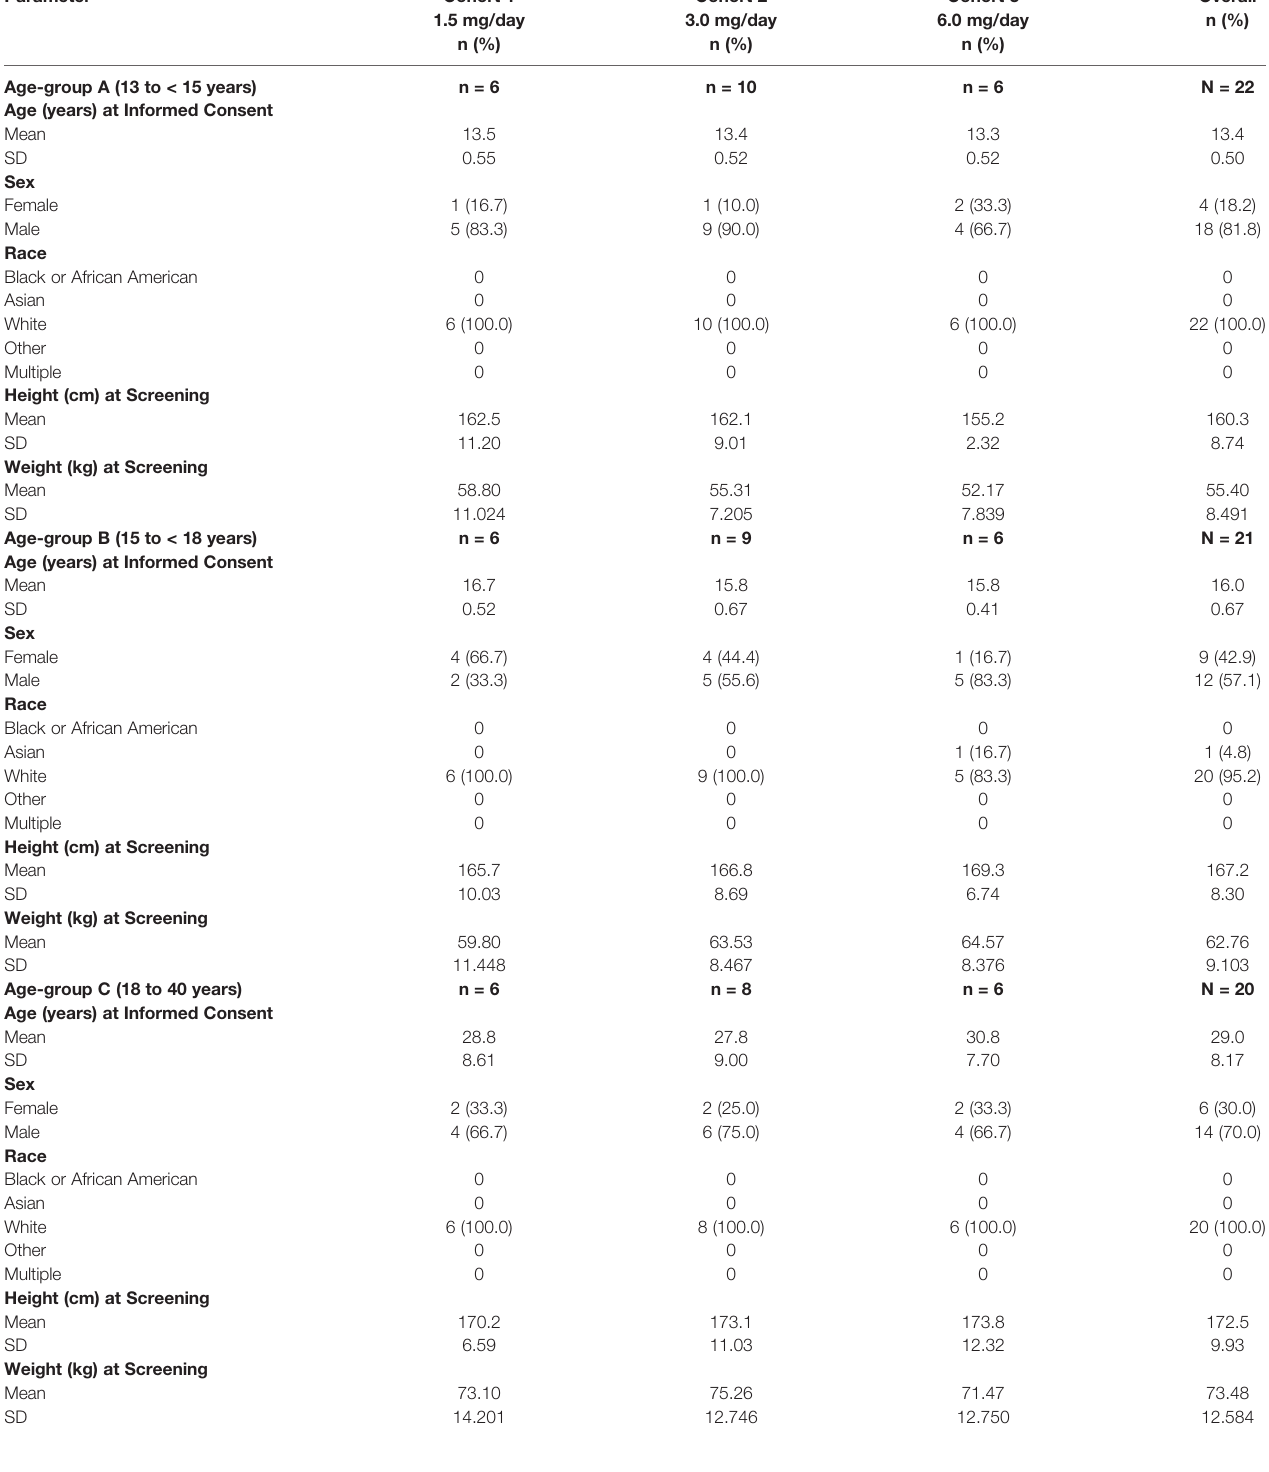
TABLE 2 | Demographics and other baseline characteristics (Safety Analysis